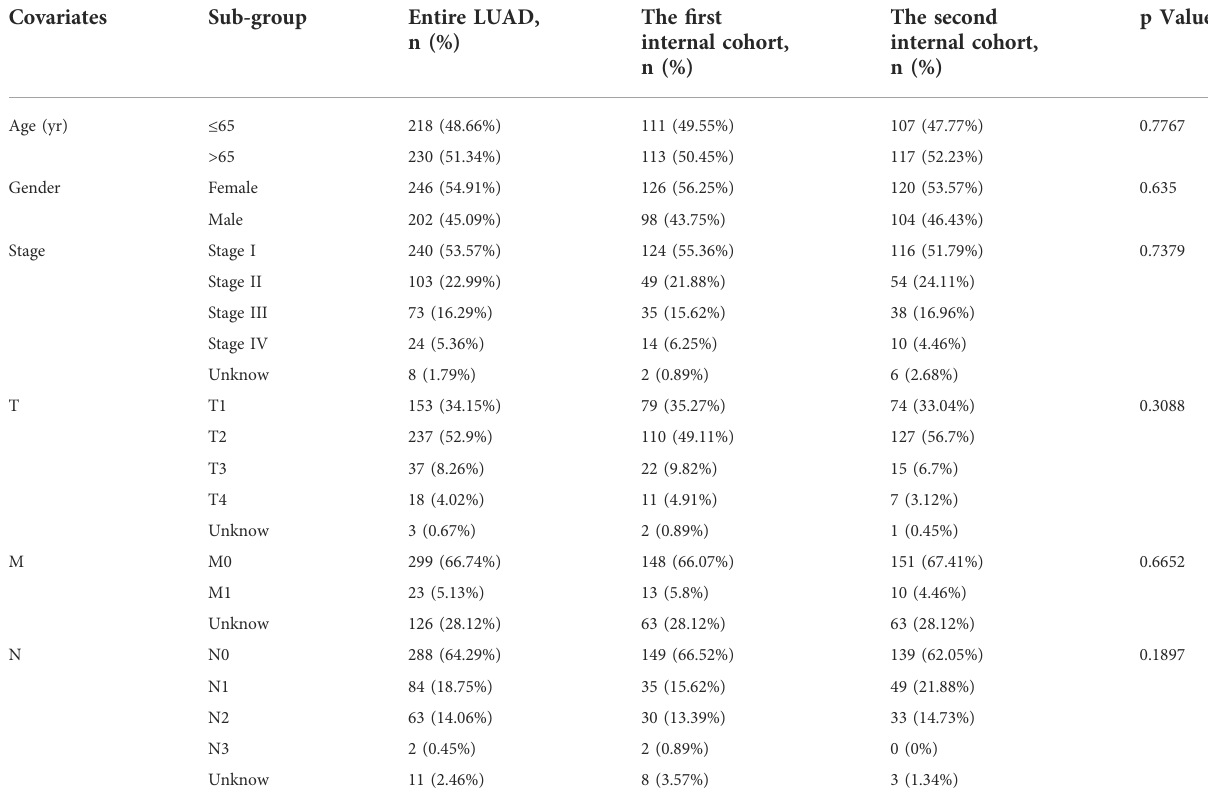
TABLE 1 Clinical characteristics of the cancer genome atlas lung adenocarcinoma the fi rst internal cohort and the second internal cohort ( n = 448).